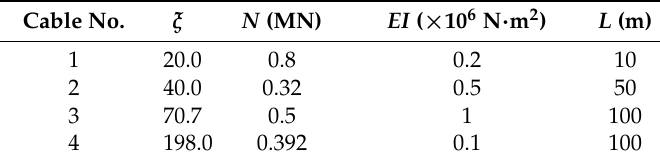
Figure 2. Cable model with hinged ends. Table 1. Structural properties of four cables with no sag.